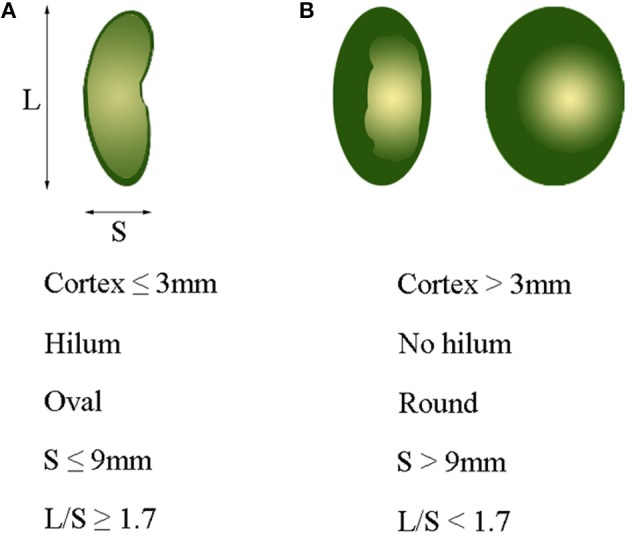
Optimal cutoff value of variables for identifying metastatic axillary lymph nodes. (A) Cortex ≤3 mm, presence of hilum, oval shape, S ≤ 9 mm, and L/S ≥ 1.7 usually indicate a normal lymph node. (B) Cortex >3 mm, non-hilum, round shape, S > 9 mm, and L/S < 1.7 mostly indicate a metastatic lymph node. L, long-axis diameter; S, short-axis diameter; L/S, ratio of long-/short-axis.